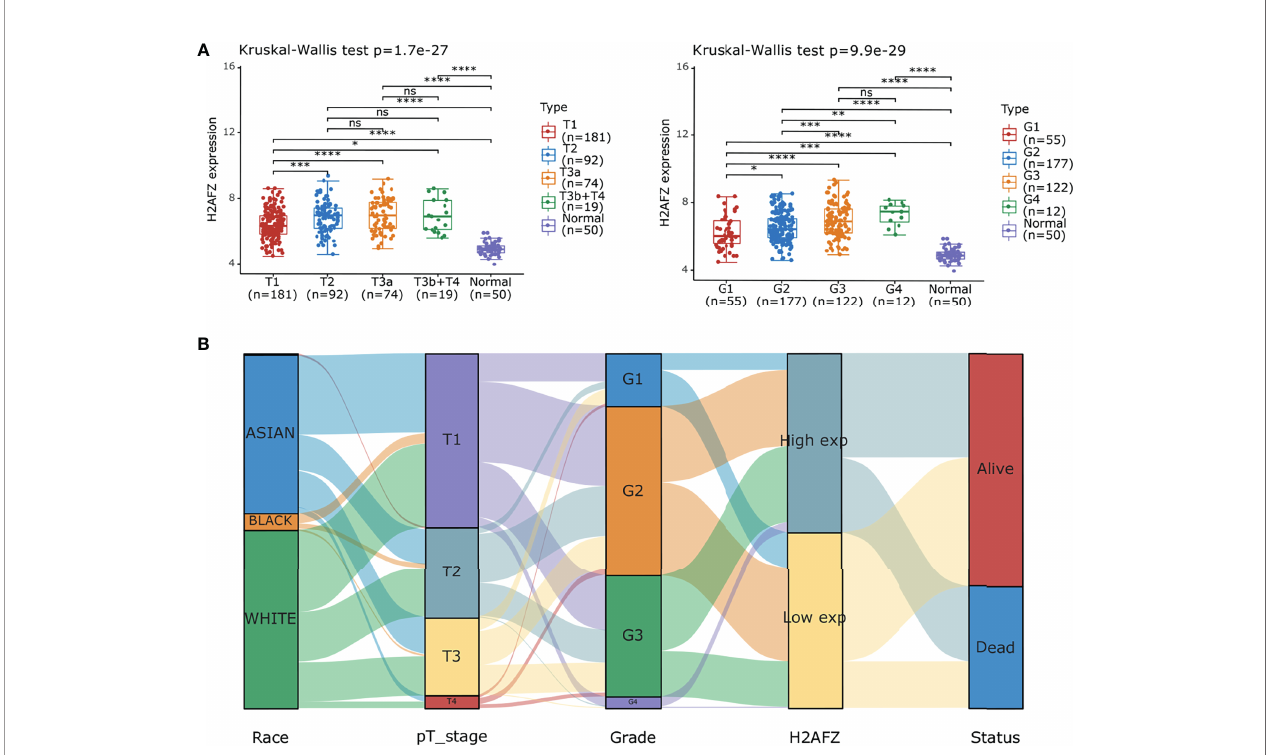
FIGURE 2 | Correlation of H2AFZ and clinical-pathological features of HCC. (A) Box-dot plots showing the expression of H2AFZ in subgroups of TCGA-LIHC samples. (B) Sankey diagram presenting the distribution trend of H2AFZ on clinical – pathological features and survival outcomes of TCGA-LIHC patients. Mann-